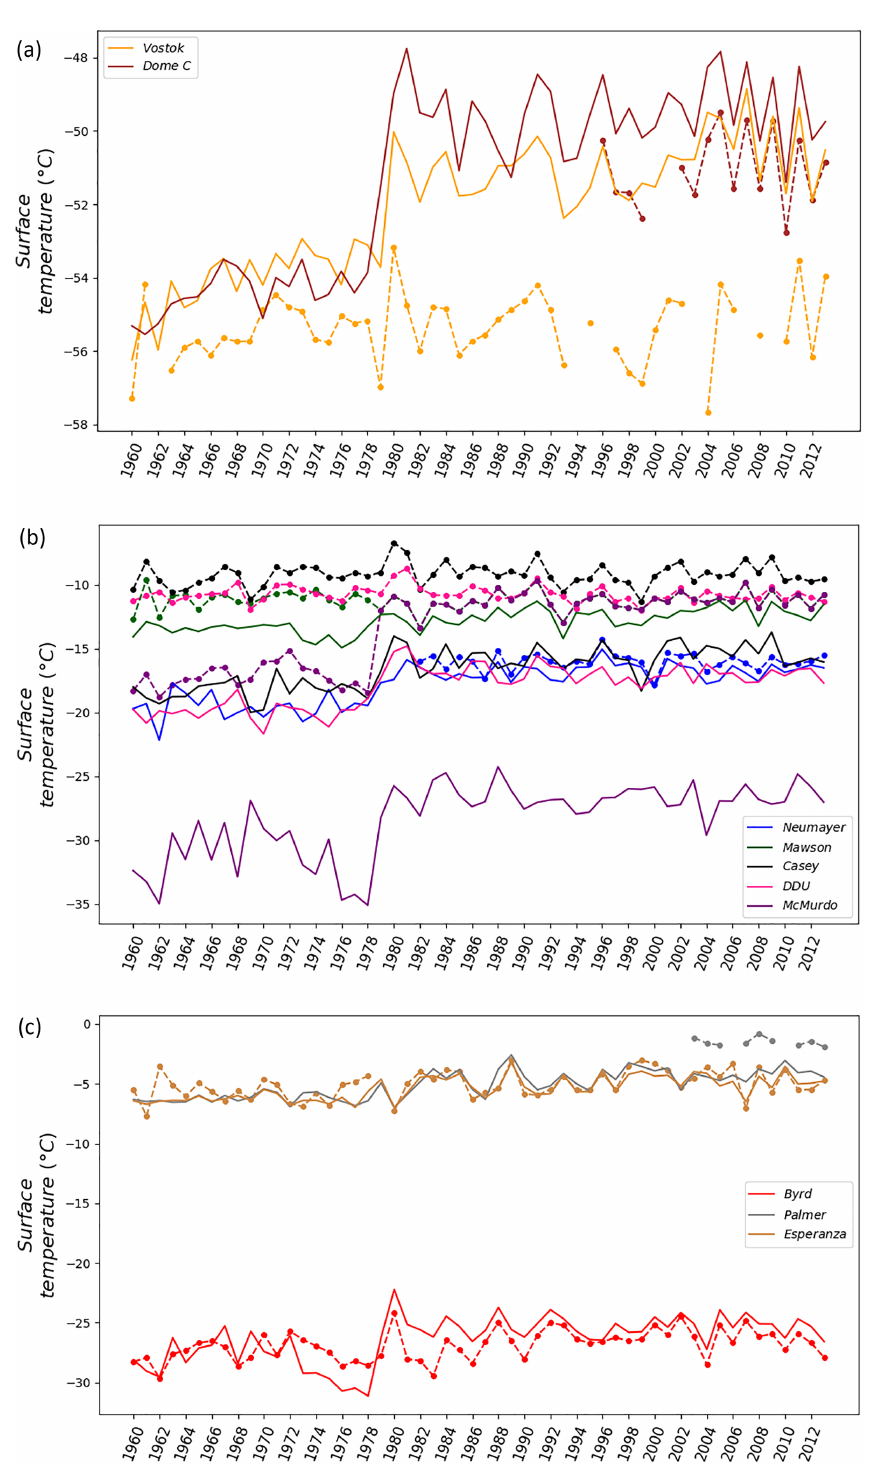
Figure 2. Surface air temperature (in ◦ C) from station instrumental records (points and dashed lines) and simulated by the ECHAM5-wiso model (solid lines) over the period 1960–2013 for (a) the plateau, (b) coastal East Antarctic Ice Sheet, and (c) the West Antarctic Ice Sheet. Note that the plots were organised by regions to make it more readable: inland (a) , coastal (b) , and West Antarctic Ice Sheet plus peninsula (c)